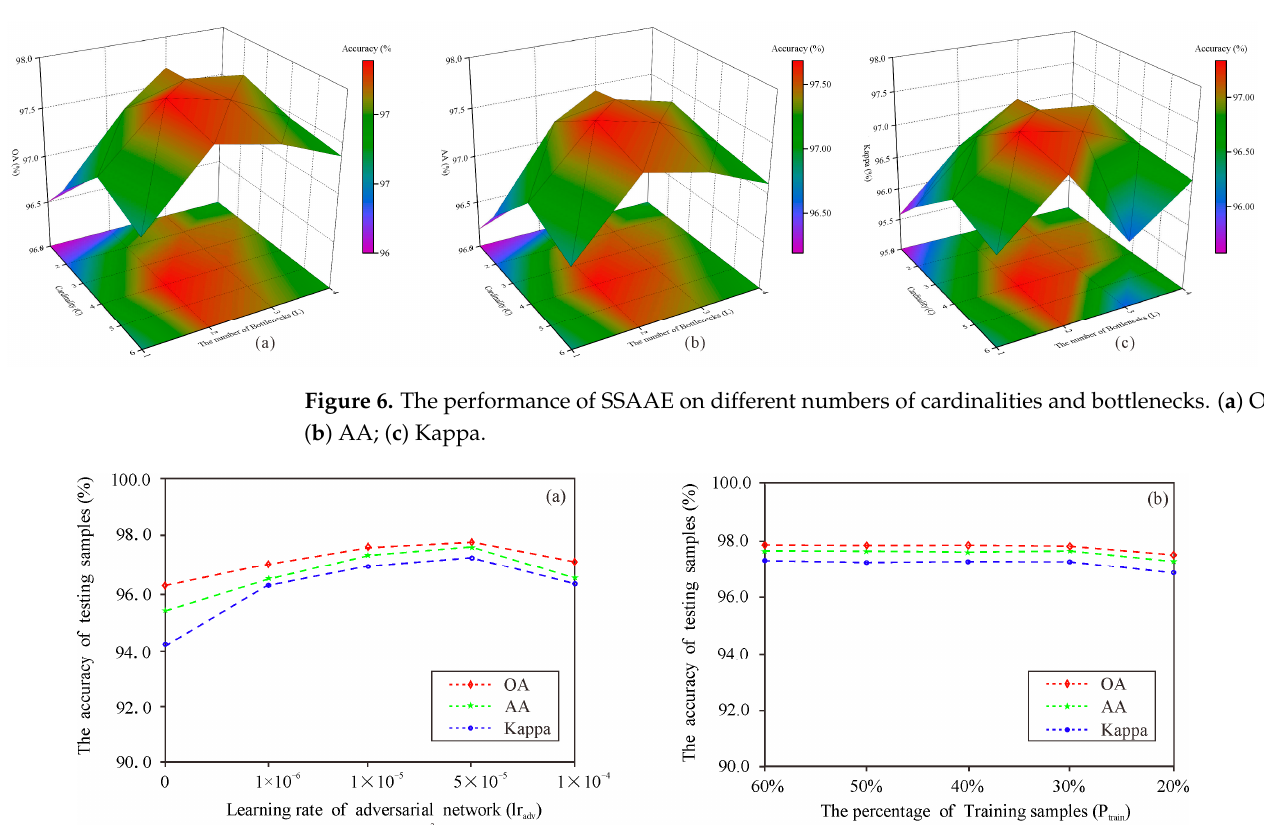
Table 3. Comparison of classification results using different methods on the synthetic dataset. Unsupervised